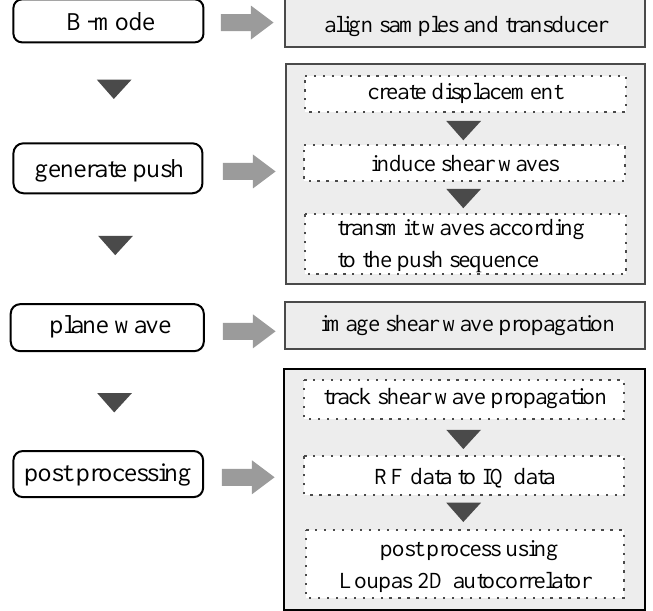
Figure 6. Procedure for tissue motion estimation using Shear Wave Elastography Imaging (SWEI)